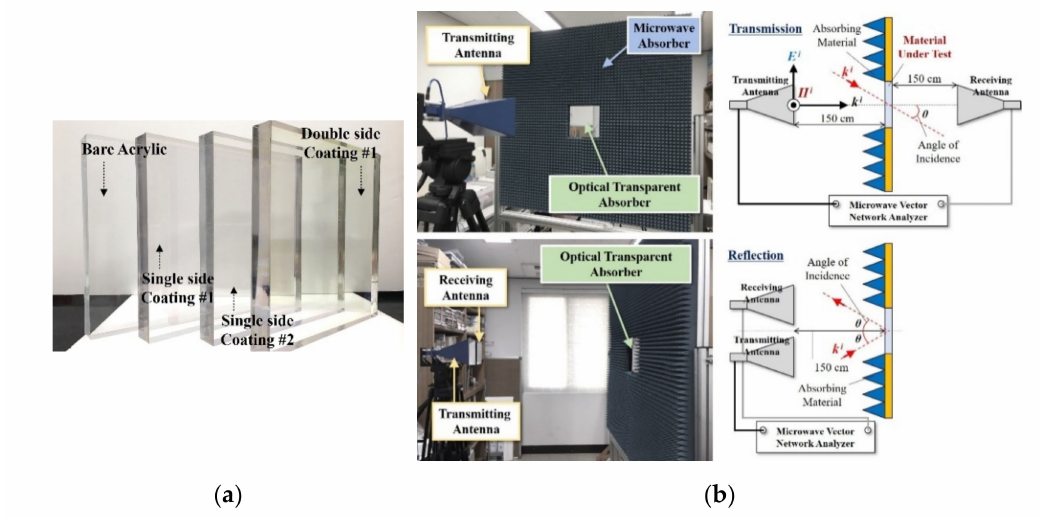
Figure 3. The fabricated optical transparent absorber and measurement environment for evaluating the electromagnetic wave transmission/reflection characteristics: ( a ) the optical transparent absorber sample and the ( b ) measurement